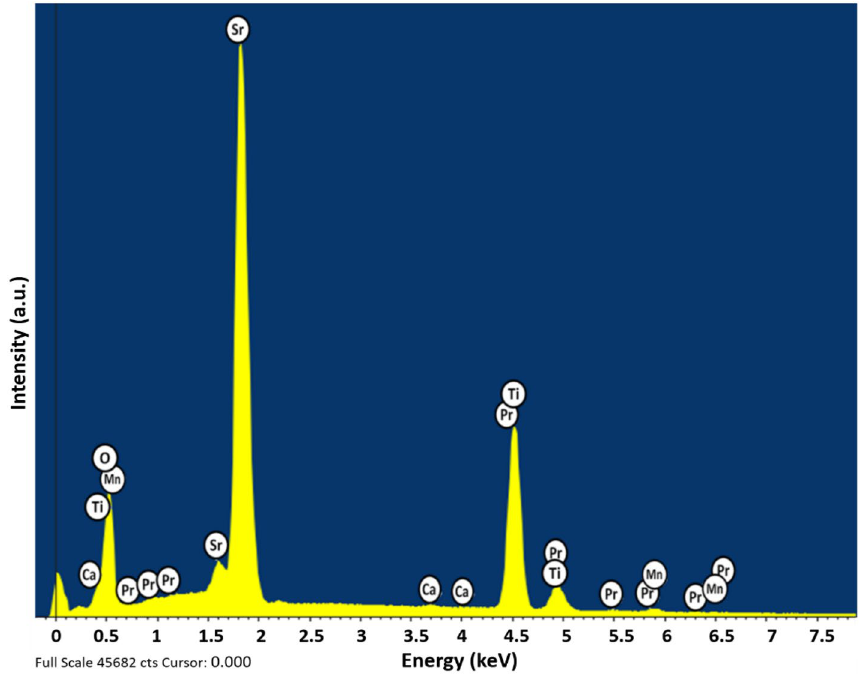
Figure 3. EDS spectrum obtained for PSMO/PCMO/STO heterostructure.